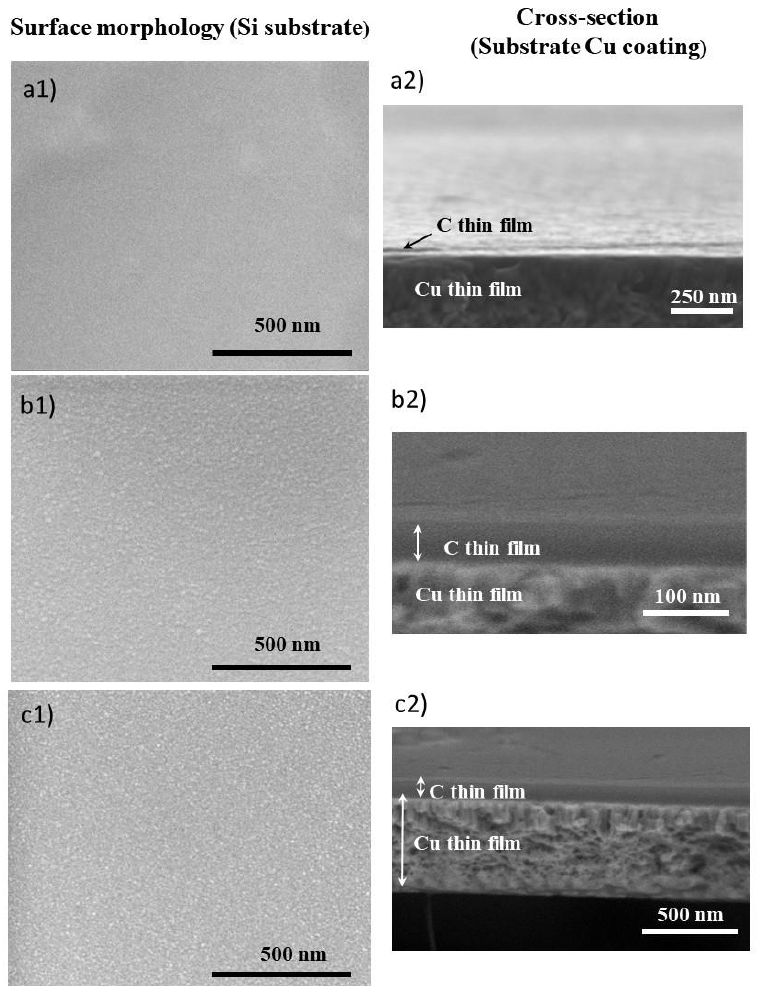
Figure 1. Scanning electron microscopy (SEM) micrographs of C thin films ( a ) C15, ( b ) C60, ( c ) C100. Surface morphology onto Si substrate and cross-section onto Cu thin film.